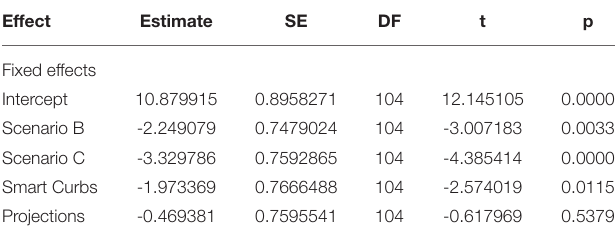
TABLE 1 | Time measurement in